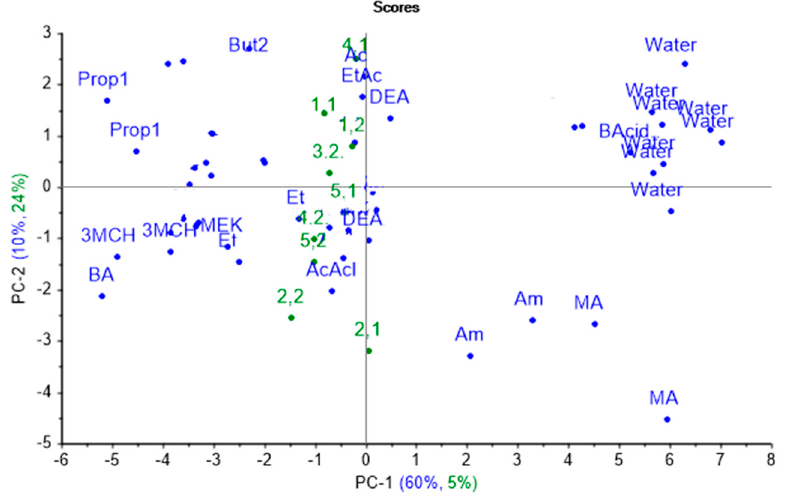
Figure 5. Projection of the spectra of cross mass-sensitivity parameters for nasal swab samples onto the PCA model for individual substances.